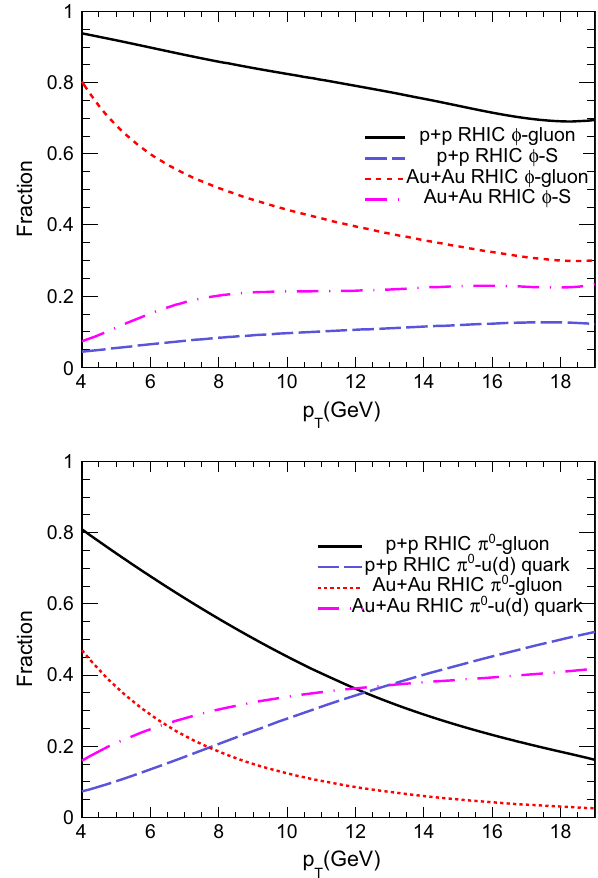
Fig. 5 Gluon and quark contribution fractions of the total φ yield ( top panel ) as well as π 0 yield ( bottom panel ) in p + p collisions and central Au + Au collisions at the RHIC